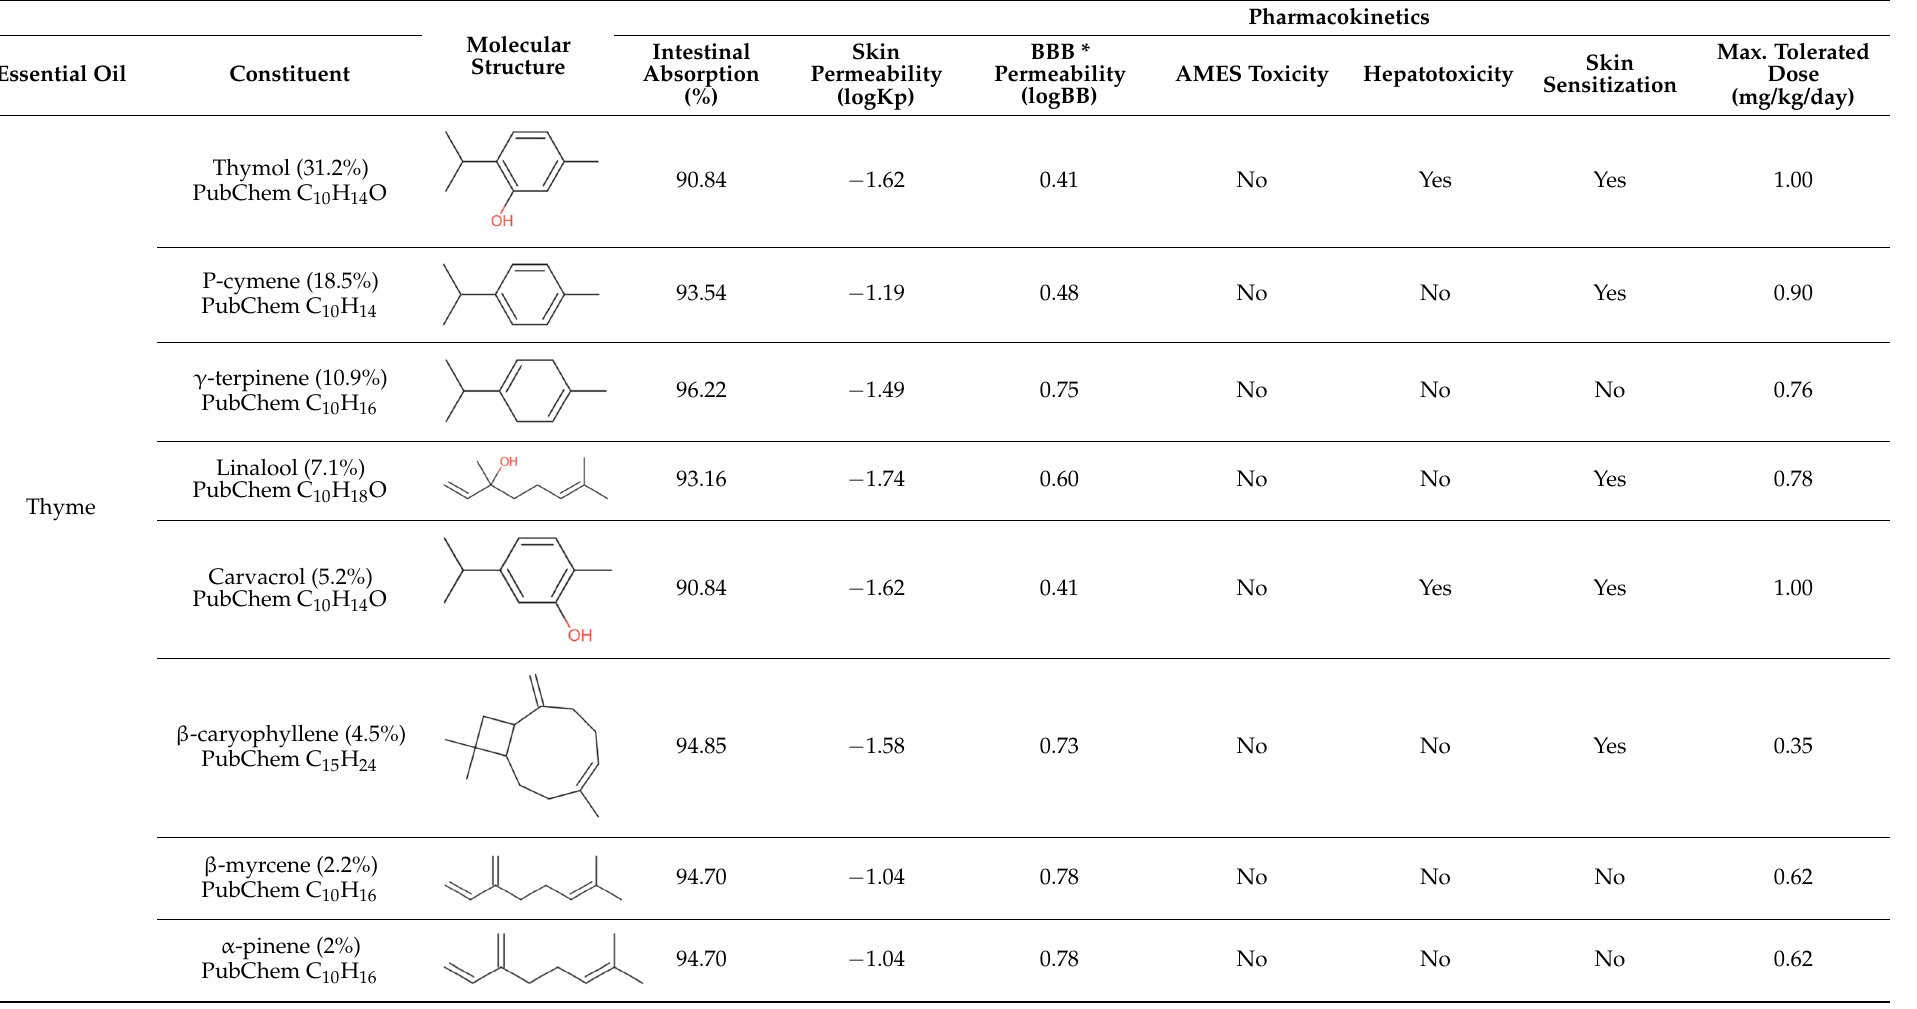
Table 9. Schematic overview of the molecular structure and pharmacokinetic properties (intestinal absorption, skin permeability, BBB permeability, AMES toxicity, hepatotoxicity, skin sensitization and maximum tolerated dose) of thyme and lemongrass EO constituents.